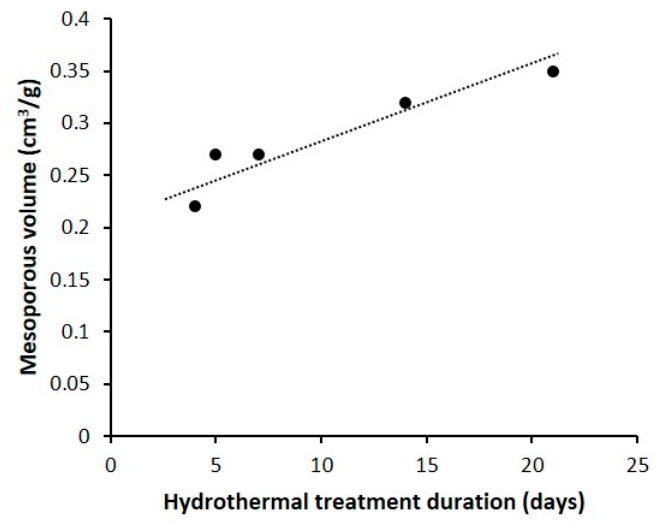
Figure 5. Evolution of the mesoporous volume of 4-NS, 5-NS, 7-NS, 14-NS and 21-NS samples (without interparticle porosity for 4-NS sample) with the hydrothermal treatment duration. Table 1. Textural properties of the calcined obtained samples and weight losses determined by TGA on as-made samples.